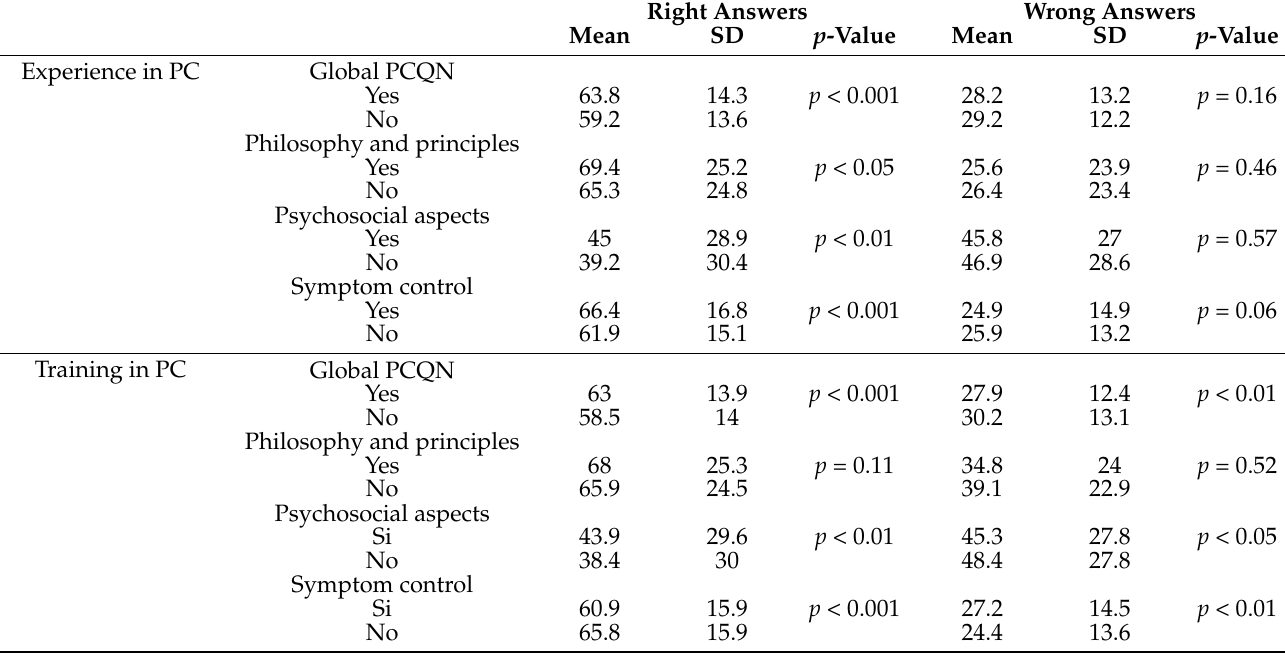
Table 5. The percentages of right and wrong answers in the global questionnaire and each subscale. Right